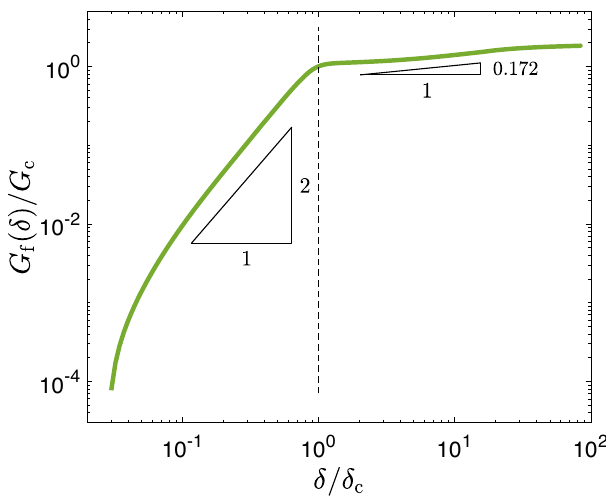
Fig. 5 The slip dependence of rupture-related dissipation. G f ( δ ), de fi ned in Eq. (7), for the very same rupture simulation whose results are presented in Figs. 3-4 (for the observation point x 1 / W = 0.3). G f ( δ ) features two power laws, marked by the two triangles, in agreement with the theoretical predictions in Eqs. (8) – (9). The crossover between the two power laws, marked by the vertical dashed line, occurs at ( δ c , G c ), as predicted theoretically. G c and δ c are used to normalize G f and δ , respectively (the value used for the former, G c = 0.51J/m 2 , is slightly smaller than the one observed in Fig. 3a due to the difference in the de fi nition of G f and E BD ). Finally, comparing the power-law exponent in the δ > δ c regime, 0.172, to the analytic prediction in Eq. (9) and using the transformation ξ ¼ (cid:1) 1 ð 1 (cid:1) Δ ξ Þ (cf. Eq. (6)), one obtains Δ ξ = 0.094. The latter is in perfect 2 quantitative agreement with Δ ξ extracted in Fig. 3a (see also Eqs. (3 –